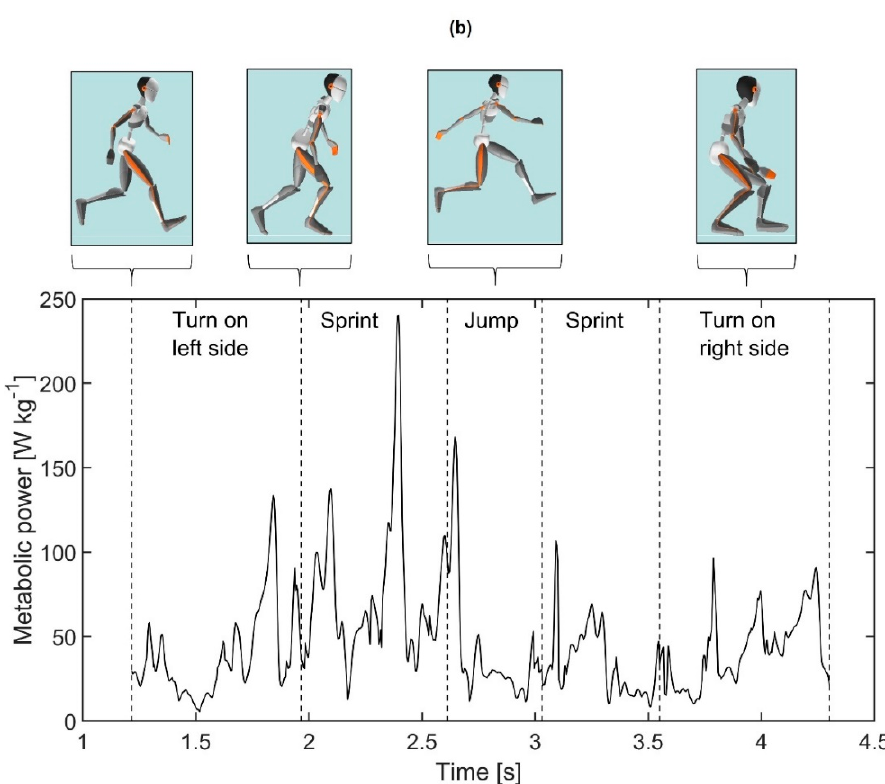
Figure 7. Course of the metabolic power for subject 8. ( a ) Metabolic power normalized to body weight during the agility run. Data from M0 1 , M1 1 , and M2 1 are shown. The jumps over the hurdles during the run are marked. A part of the agility run of M0 1 , denoted with the red rectangular, is zoomed in on in ( b ). Specific movements during the agility run are marked.